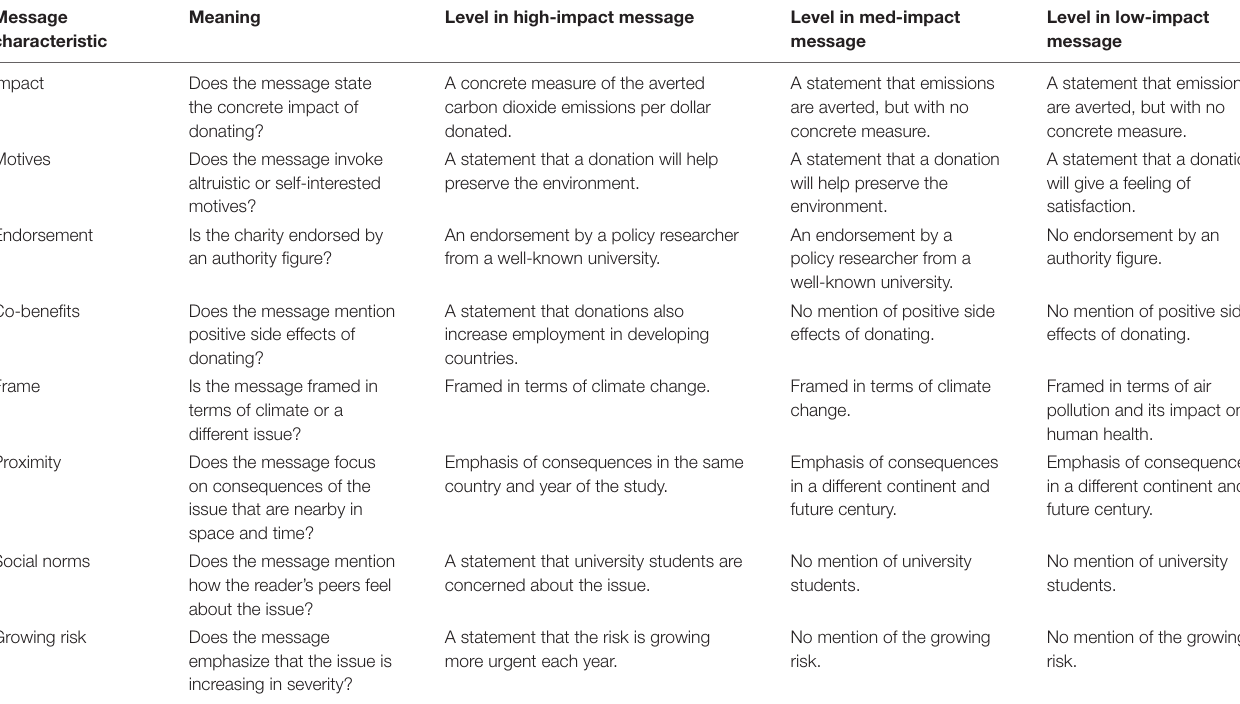
TABLE 1 | The eight components used to craft messages of different impact levels.